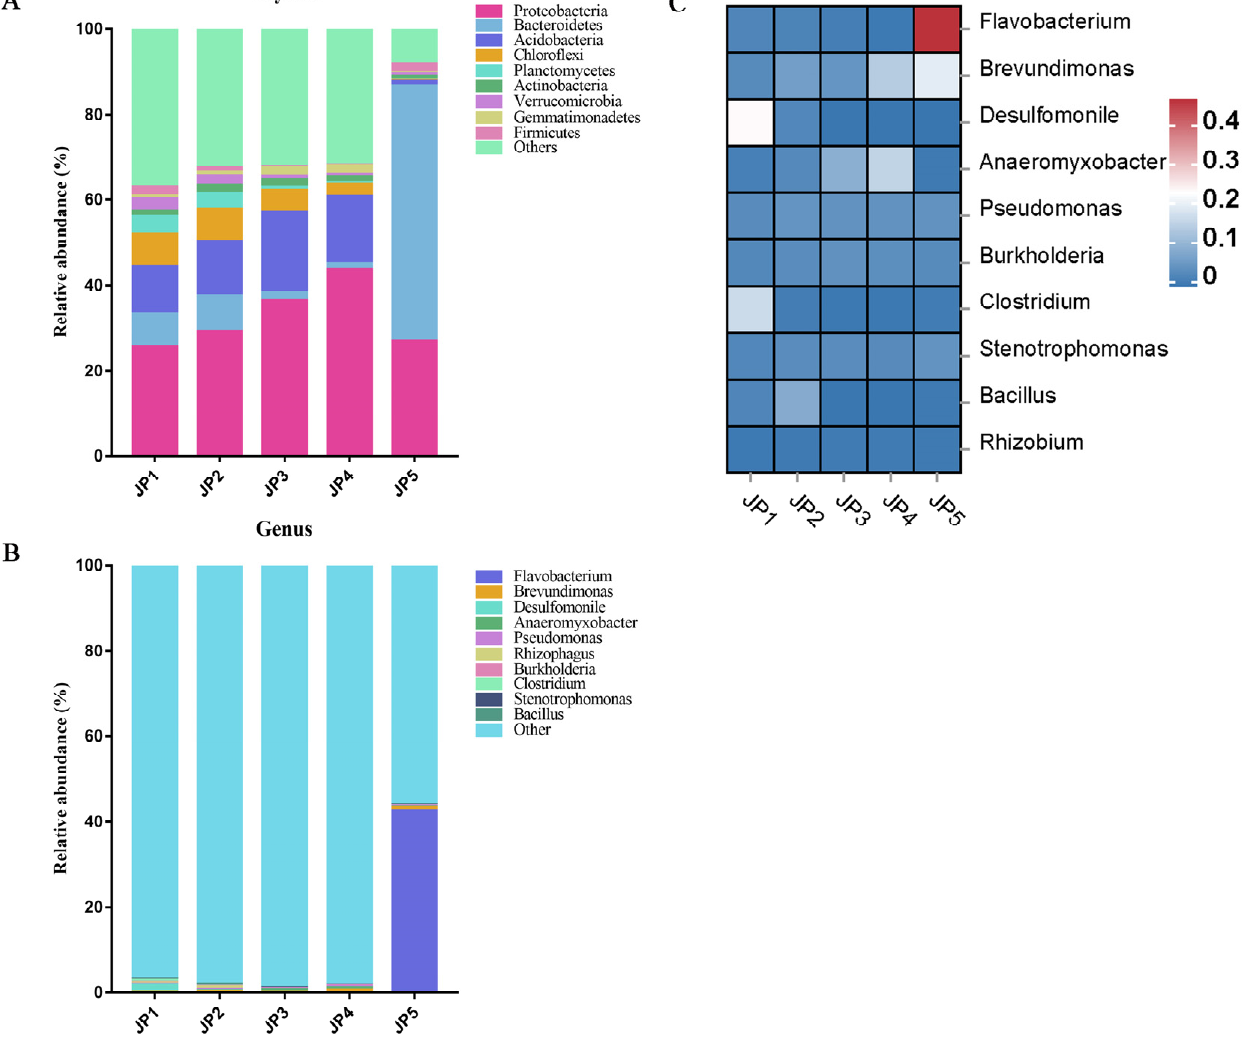
Figure 2. Microbial community composition of sediment at five different locations of Jingpo Lake. Phylum ( A ) and genus ( B ) abundance comparison among five different regions of Jingpo Lake. ( C ) Heatmap of differentially abundant bacterial genera. Color scale represents the row-scaled, log-transformed relative abundances of genera.